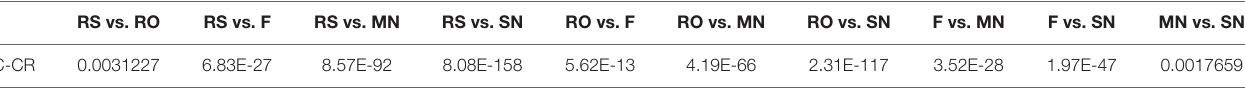
TABLE 6 | The uncorrected pairwise comparison results for the five subjective rating options across the four datasets [Exp 1 (loc), Exp 2 (col), Exp 3-loc, Exp 3-col]. RS vs.